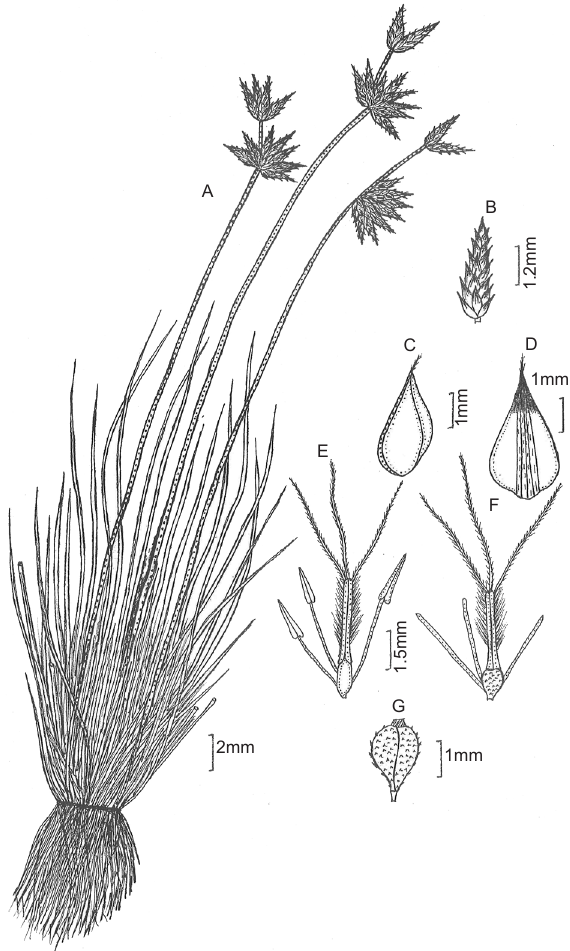
Figure 1. Fimbristylis matthewii sp. nov. A - habitat; B - spikelet; C,D - glume; E,F - pistil; G -